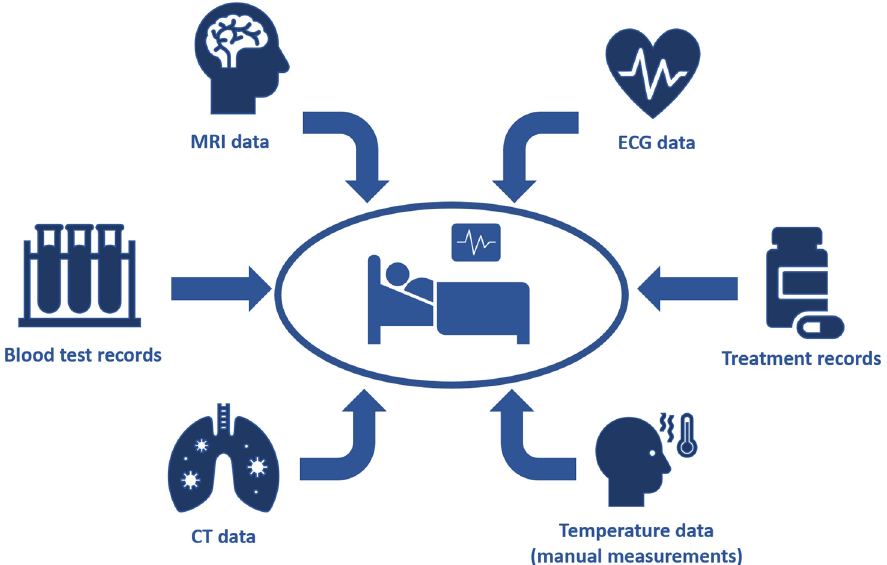
Figure 2. An example of two quasi-compatible aggregates. Figure 21. An example of temporal multimodal data processing context. Figure 21. An example of temporal multimodal data processing context. Figure 3. An example of two incompatible aggregates.